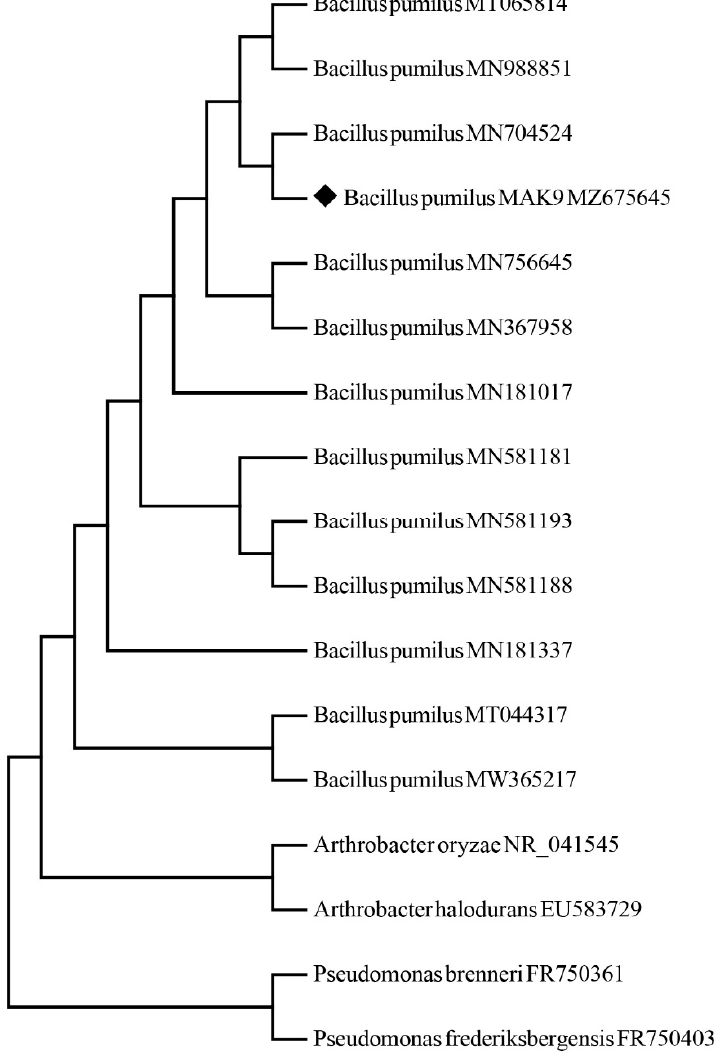
Figure 1. Phylogenetic tree of isolate MAK9 constructed using 16S rRNA sequences as well as neighbor-joining and maximum-likelihood methods. ♦ represents the bacterial strain.